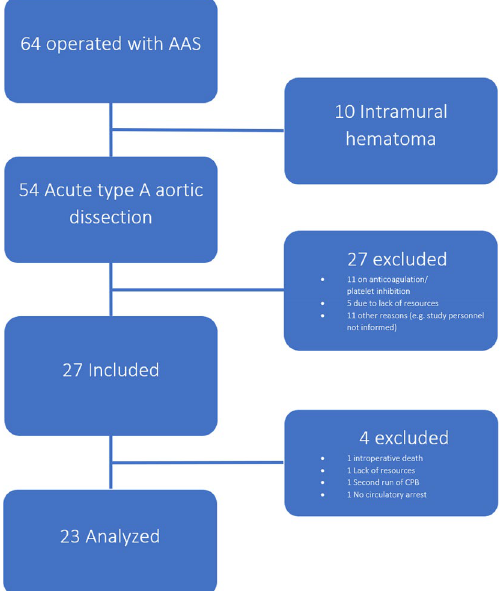
Figure 1. Flow chart of patients with acute aortic syndromes referred to the Department of Cardiothoracic Surgery, Skåne University Hospital, Lund, Sweden, during the inclusion